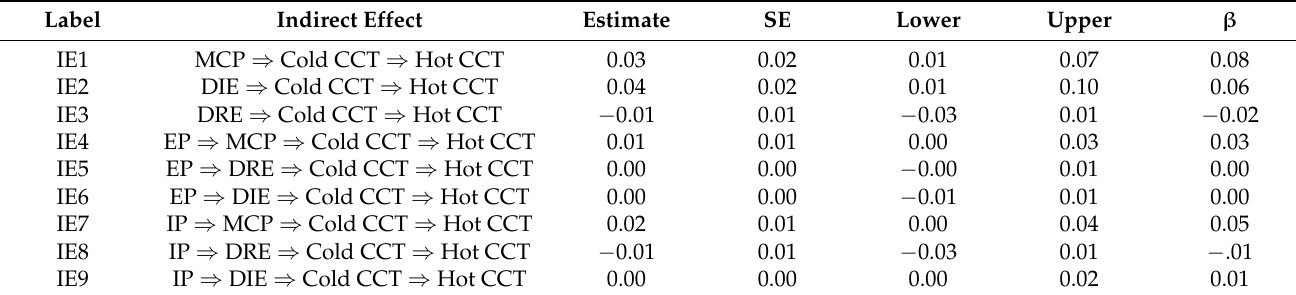
Table 2. Mediation Analyses: Test of indirect